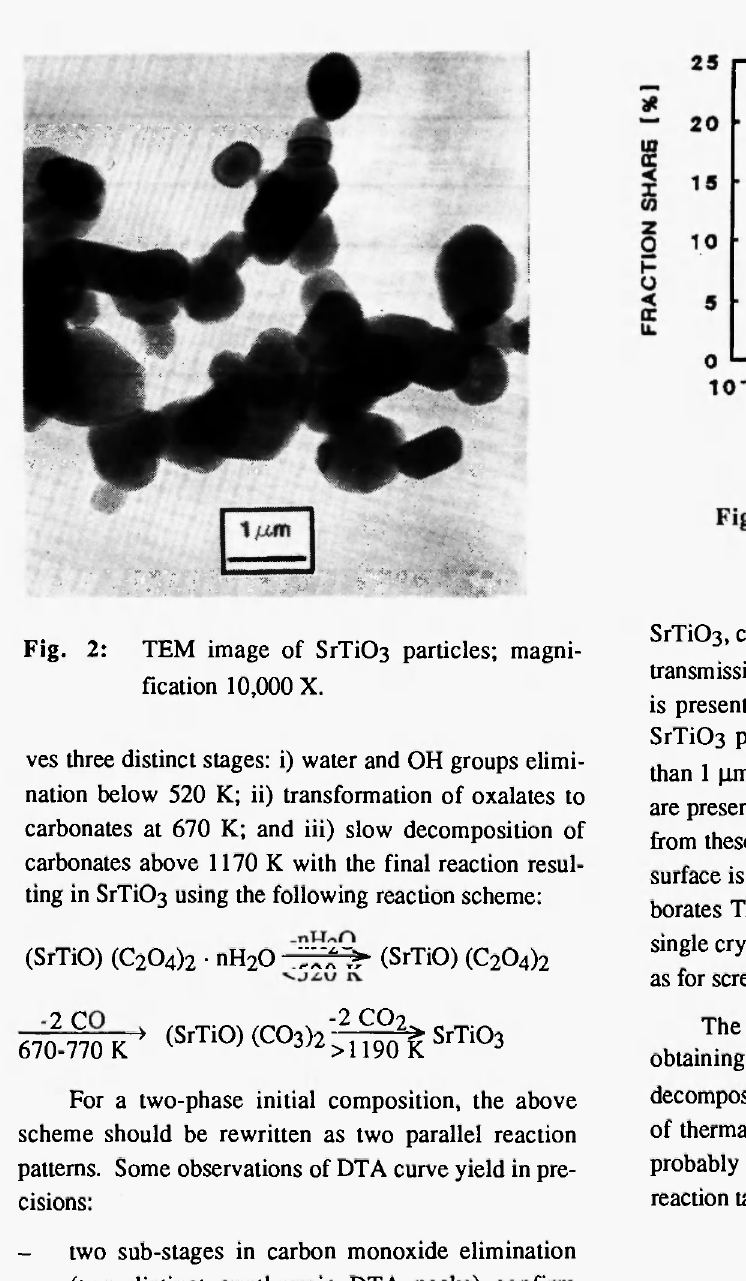
Fig. 2: TEM image of SrTiC>3 particles; magni- fication 10,000